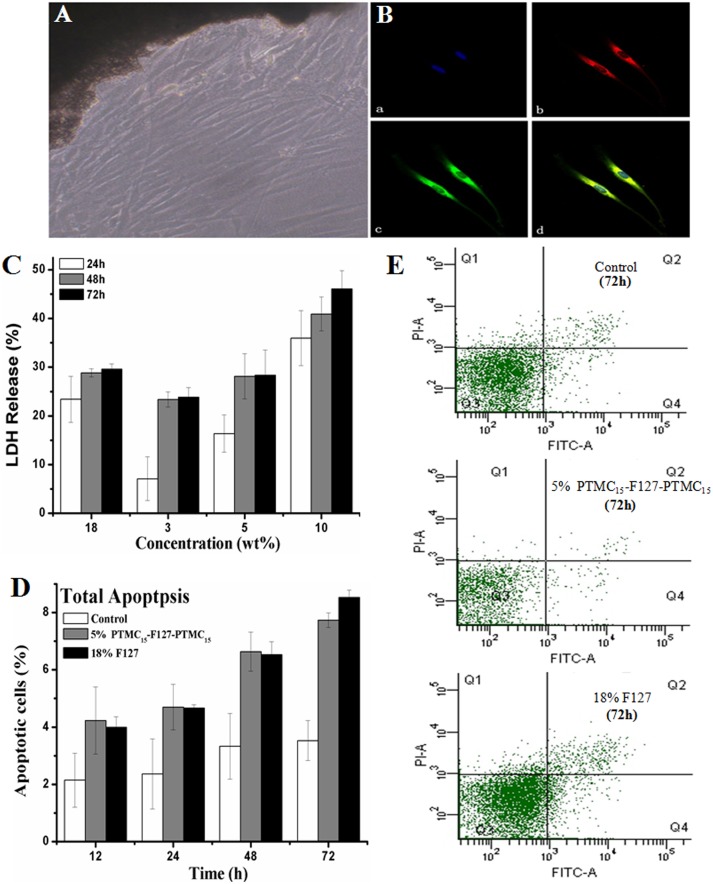
In vitro cell toxicity of the HTFs cocultured with PTMC15-F127-PTMC15 copolymer in different concentration and with F127.(A) primary cultured HTFs were identified with microscopy and (B) with immunofluorescence. (a) Negative control using DAPI dyed the nucleus (blue) of HTFs. (b) Vimentin antibody (red) was added. to primary HTFs (c) Fibronectin antibody (green) was added. (d) Melt. (C) LDH release assay were used to analyze cell toxicity in different concentration of PTMC15-F127-PTMC15 (3%, 5% and 10% w/v) and in 18% w/v F127 within 3 days. (D) Total apoptosis of HTFs incubated with 0.1 ml 5% w/v PTMC15-F127-PTMC15 or 0.1 ml 18% w/v F127 were detected by Annexin V/PI staining using fluorescence-activated cell sorting (FACS). (E) Apoptotic changes between 5% w/v PTMC15-F127-PTMC15 and 18% w/v F127 at 3 days. LDH  =  lactate dehydrogenase. ‘Control’ one is the group with no treatment.